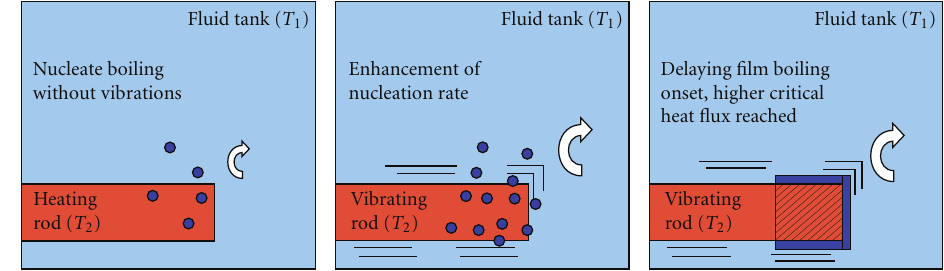
Figure 6: Enhancement of boiling heat transfer by ultrasonic